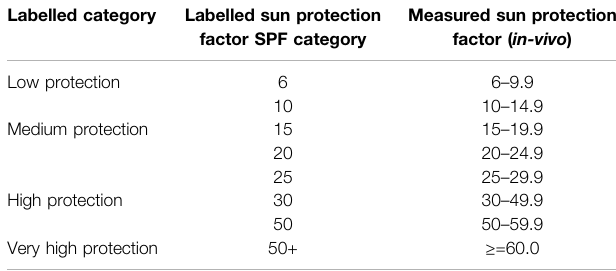
TABLE 3 | Categories of sun protection products, their respective labels, and measured SPFs according to European legislation. Labelled